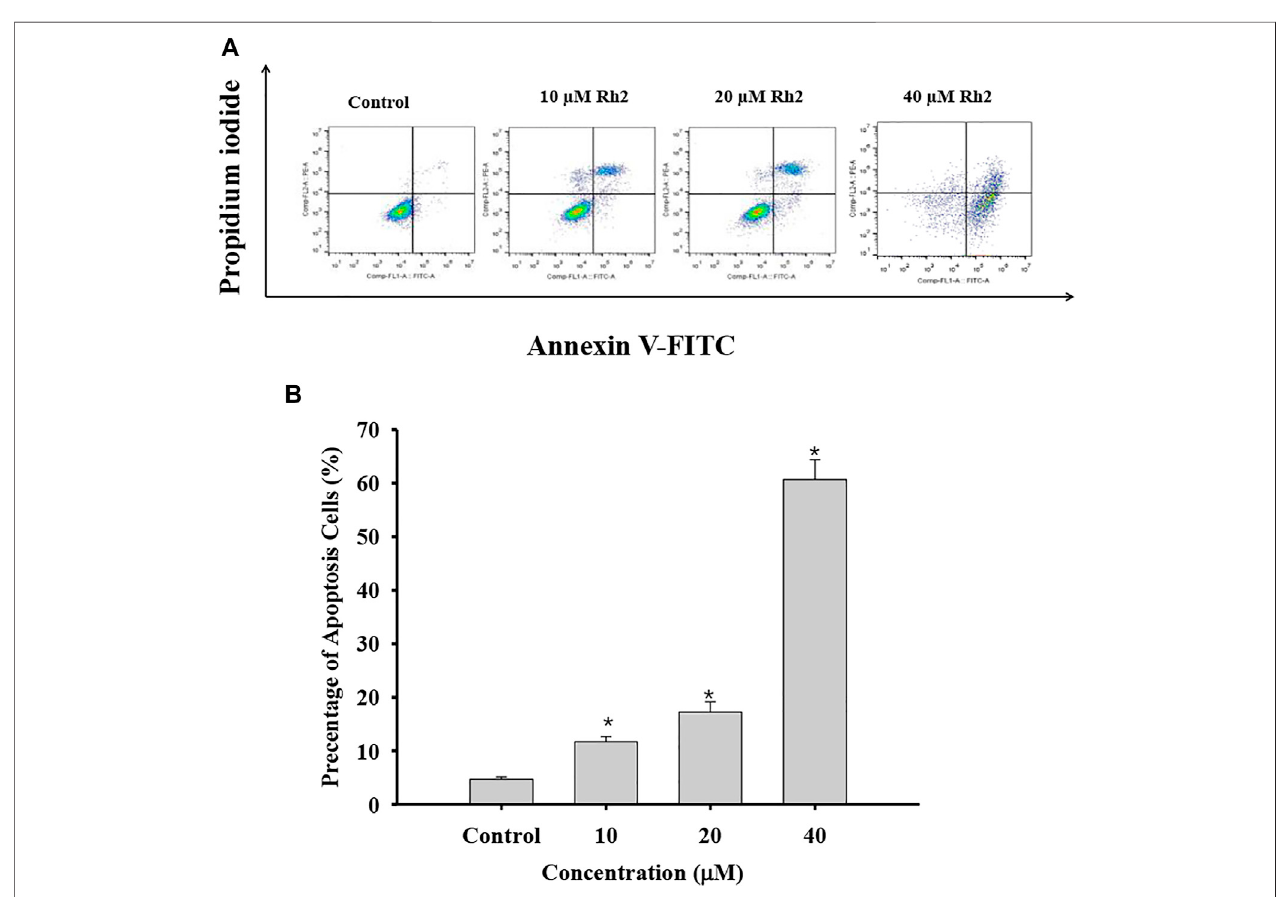
FIGURE 8 | Effect of G-Rh2 on apoptosis of A549 cells. (A) Cells were treated with G-Rh2, and the apoptotic rate was determined by Annexin V-FITC/PI staining. (B) Percentage of apoptotic cells, Values are means ± SD ( n = 3).